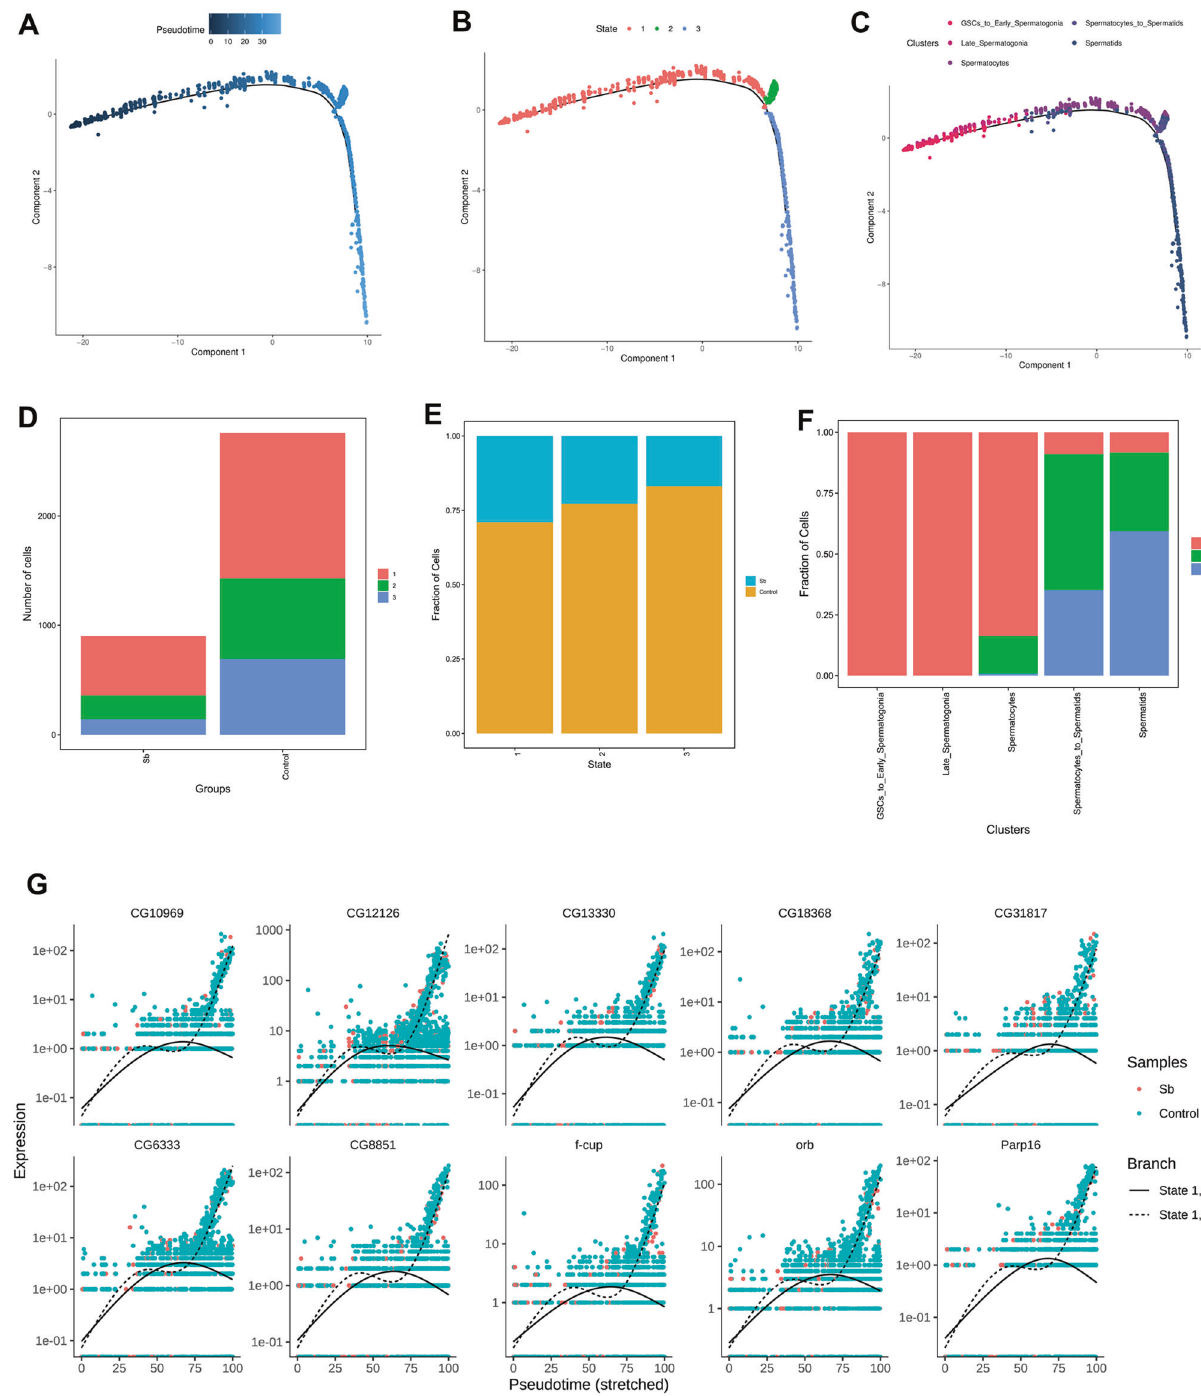
Fig. 6 Pseudotime trajectory analysis for testicular germ cell complexity during spermatogenesis. A Analysis of germ cells visualized by pseudotime trajectory plot. B Pseudotime trajectory analysis of germ cells colored by different states. C Pseudotime trajectory analysis of germ cells colored by different cell populations. D The number of testicular cells in each state of control and Sb groups. E The fraction of testicular cells in each state of control and Sb groups. F Cellular component analysis in each state during spermatogenesis. G Spline plots of representative gene expression dynamics for state 1, 2 branch and state 1, 3 branch in germ cell populations. were speci fi cally expressed in a state-biased manner. To further Importantly, germ cells in state 1 were composed of pre-meiotic distinguish gene regulation in state 1, branch 2 and state 1, GSCs/early spermatogonia and meiotic spermatocytes, while branch 3, spline plots were used to demonstrate the expression germ cells in state 2 and state 3 trended to be clustered by dynamics of the two branches. The resultant pseudotime meiotic spermatocytes and post-meiotic spermatids (Fig. 6F). analysis indicated that state 1, branch 3 directs to germ cell Consistent with the expression patterns of different cell populations with high-level expression of identi fi ed novel populations during spermatogenesis, a large number of genes Cell Death Discovery (2023)